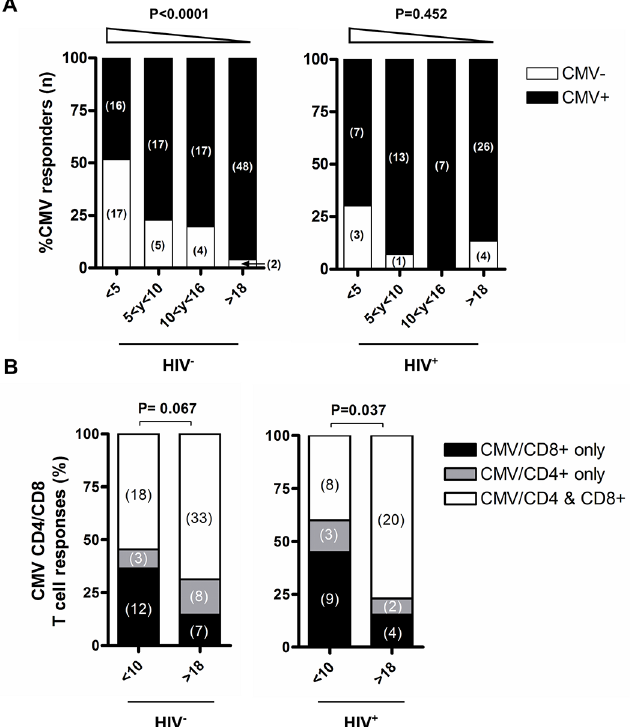
Fig 2. CMVpp65-specific T cell responses in relation to age and HIV infection status. (A) Frequency of subjects with or without CMVpp65-specific T cell responses (CD4 + or CD8 + ) is shown stratified by age group and HIV status. B) The frequency of subjects with CMVpp65-specific T cell responses distributed within the CD4 + and/or CD8 + T cell compartment is shown after stratification by HIV status. The number of subjects in each group is indicated within brackets. CMVpp65-specific T cell responses were considered positive if the frequency of IFN γ + T cells was 2-fold above the negative control and at least 0.05% of the parent population. Statistical analysis was performed using the chi-square test for trend (A) and chi-square test